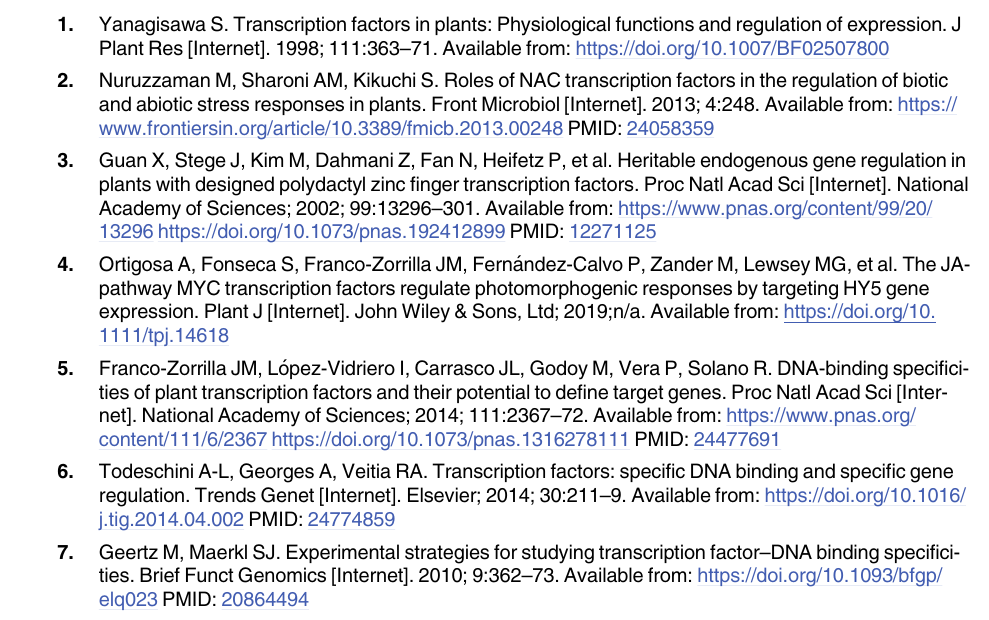
S1 Fig. Transmembrane bound NAC TF proteins. S2 Fig. Graphical presentation of nuclear localization signal sequences of NAC TF pro- teins. S3 Fig. The presence of L-V-F-Y/H conserved motif in NAC TFs of plants ( A . thaliana ).